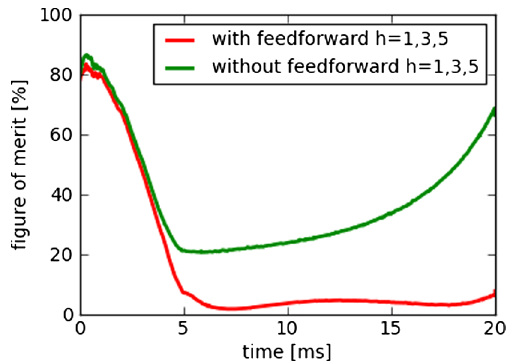
FIG. 3. A comparison of the FOM from injection to extraction with and without feedforward for the odd harmonics. Note that the FOM does not characterize the distortion very well until 5 ms, because the cavity is driven by dual